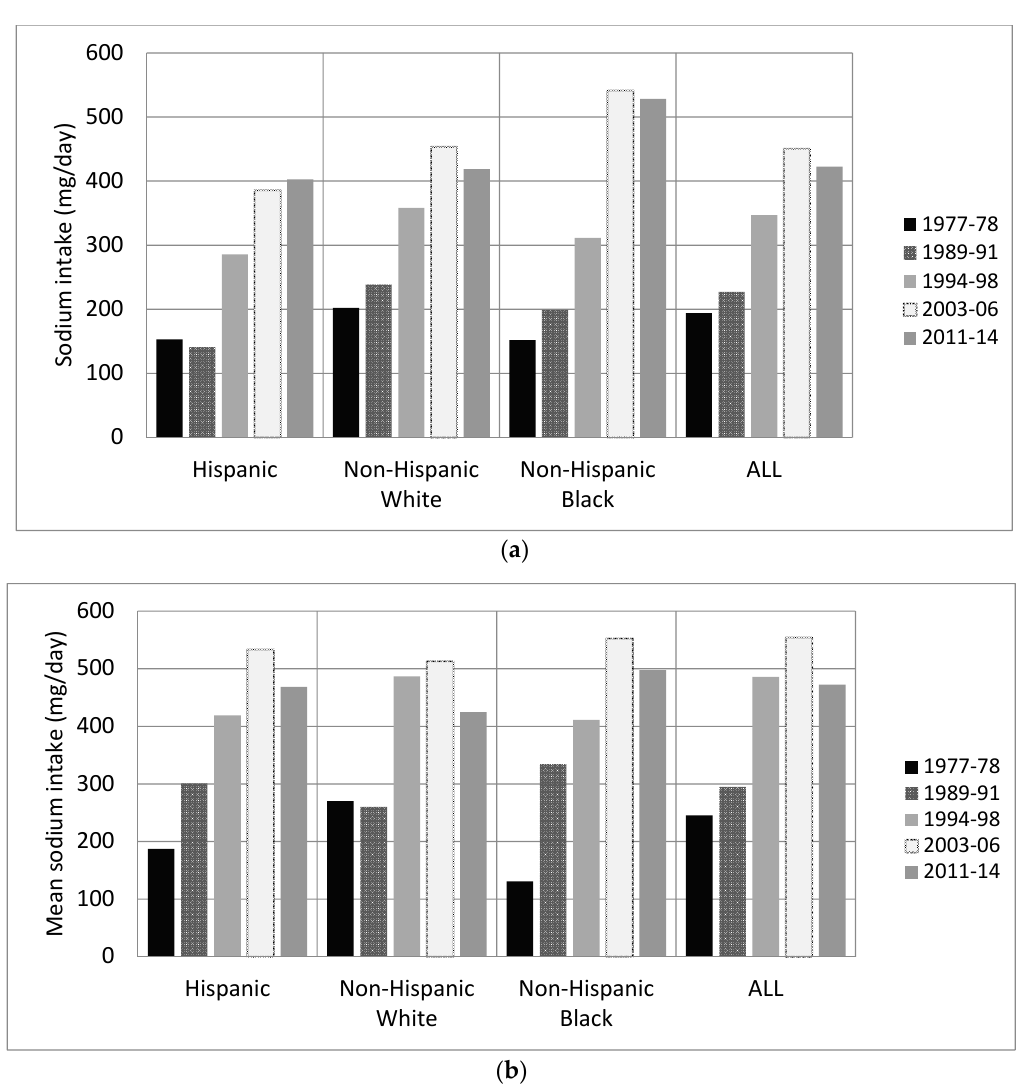
Figure 1. Sodium intake from snack food sources overall by race-ethnic group in US adults and children ( a ) Adults; ( b ) Children.